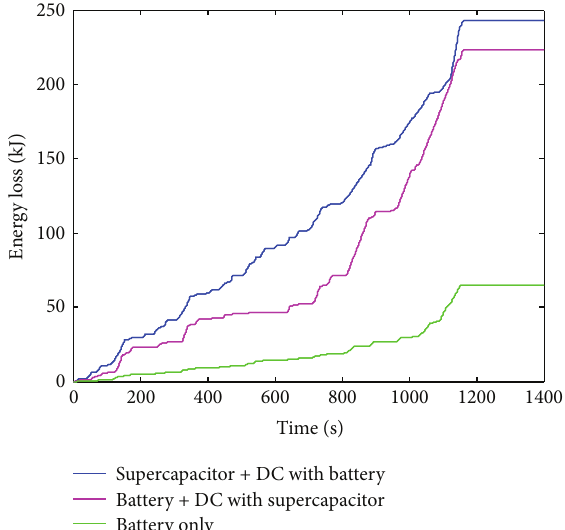
Figure 35: Energy loss comparisons of two semiactive topological structures and battery only system for NEDC driving cycle.